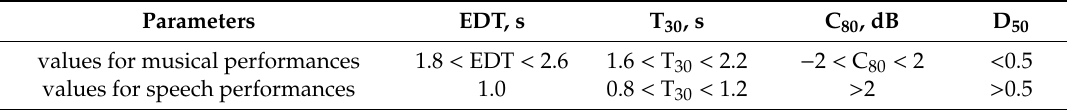
Table 1. Suitable acoustic parameter values for the di ff erent listening conditions. Parameters EDT, s T 30 , s C 80 , dB D 50 values for musical performances 1.8 < EDT < 2.6 values for speech